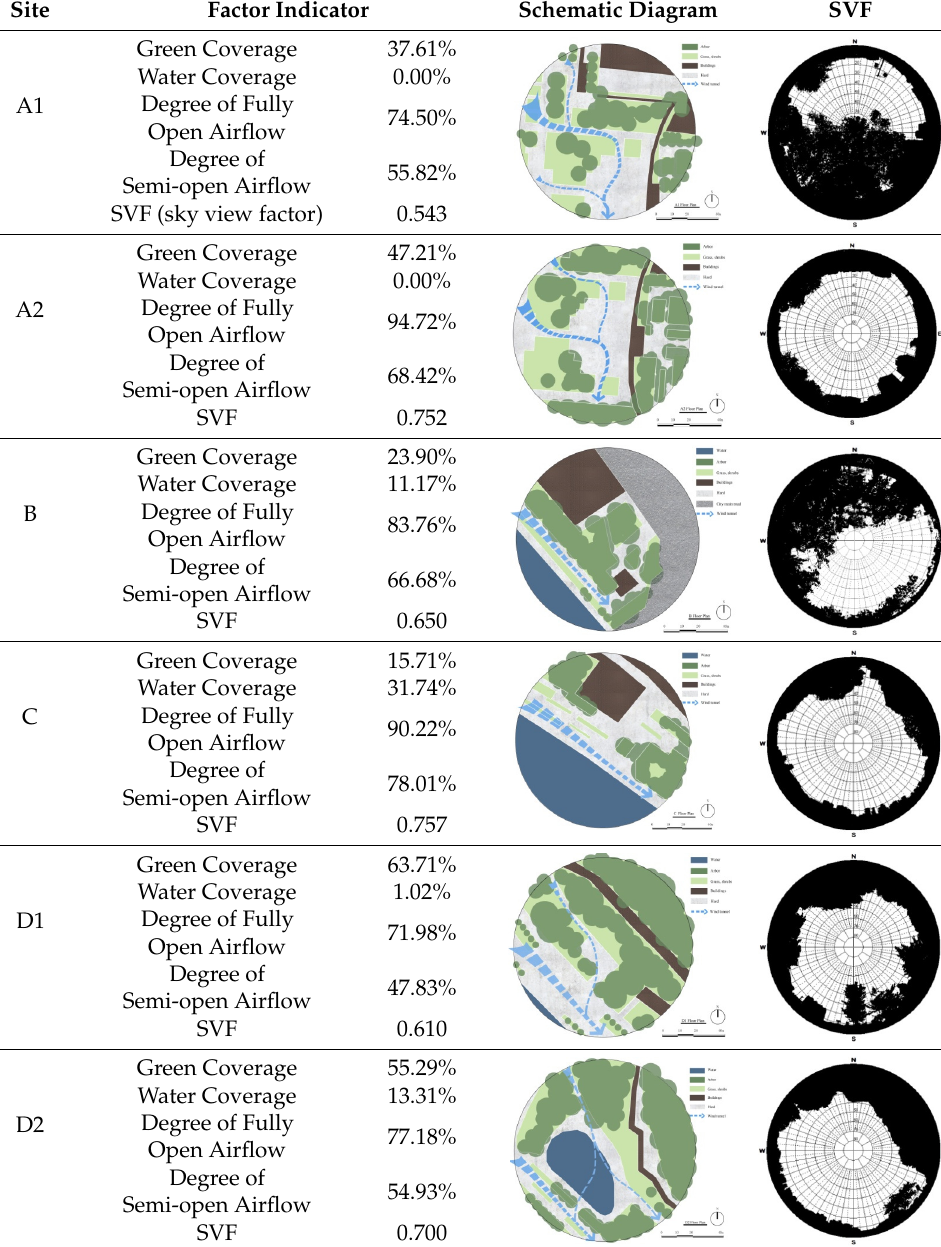
Table 3. Physical factor index of research sites.